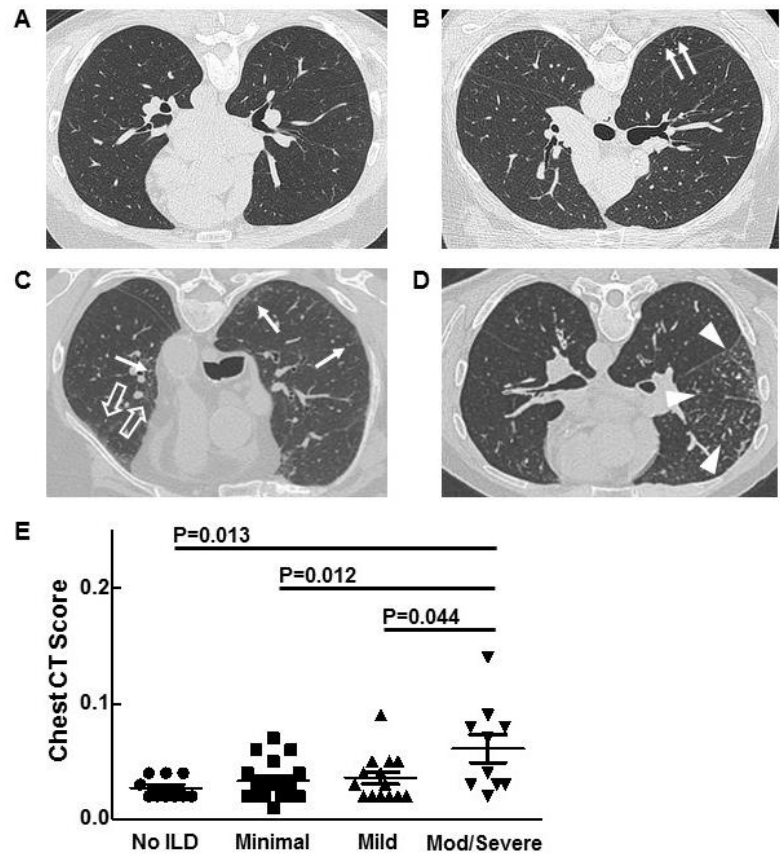
Figure 1. Representative high-resolution chest-computed tomography scan images from patients with Erdheim–Chester disease (ECD) and no interstitial lung disease (ILD) ( A ), minimal ILD with subpleural reticulations (arrows) ( B ), mild ILD with reticular ground-glass opacification (open arrow) ( C ), and moderate (mod) ILD with reticular nodular opacity (arrow heads) ( D ), are shown. Chest-computed tomography scan scores for patients with ECD and varying severity of ILD are displayed ( E ). Table 1. Clinical Characteristics of Patients with Erdheim–Chester Disease.